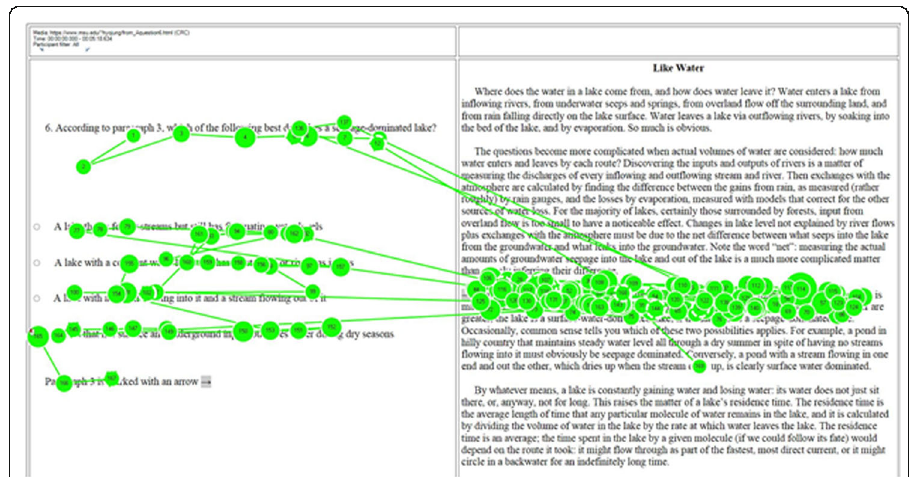
Fig. 6 Gaze plot from the unsuccessful candidate (ID82) on item 6